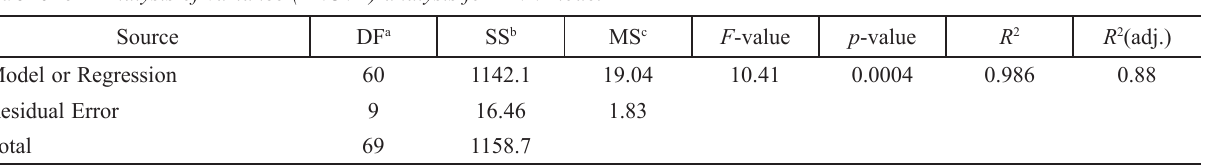
Table 6 – Analysis of variance (ANOVA) analysis for ANN model